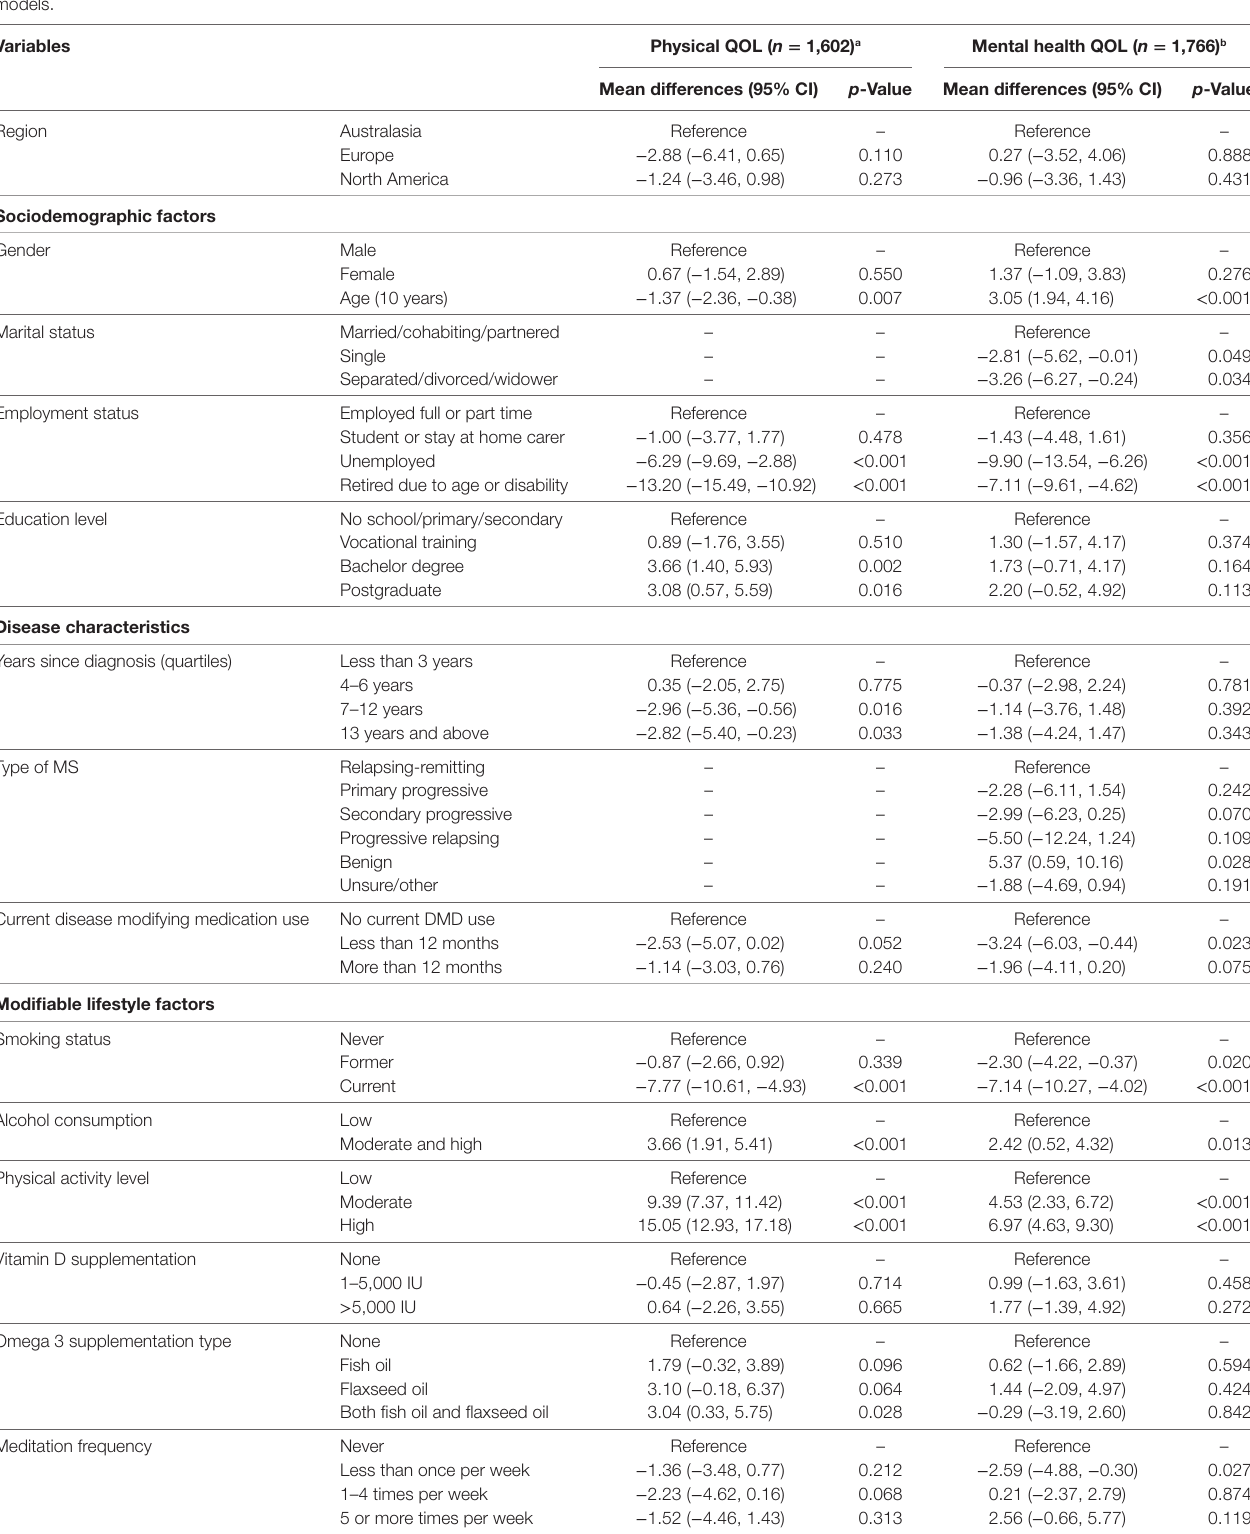
Table 3 | Associations between regions and other covariates with physical and mental health quality of life (QOL) obtained using multivariable linear regression